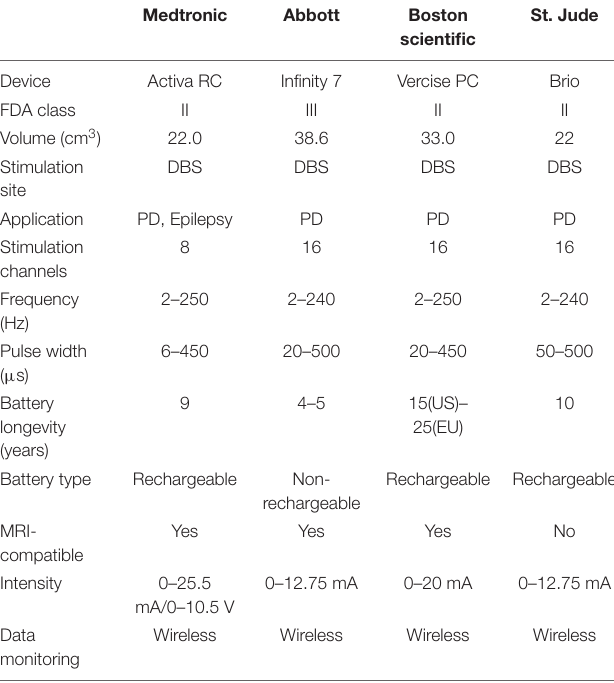
TABLE 1 | Open-loop neural stimulation system.